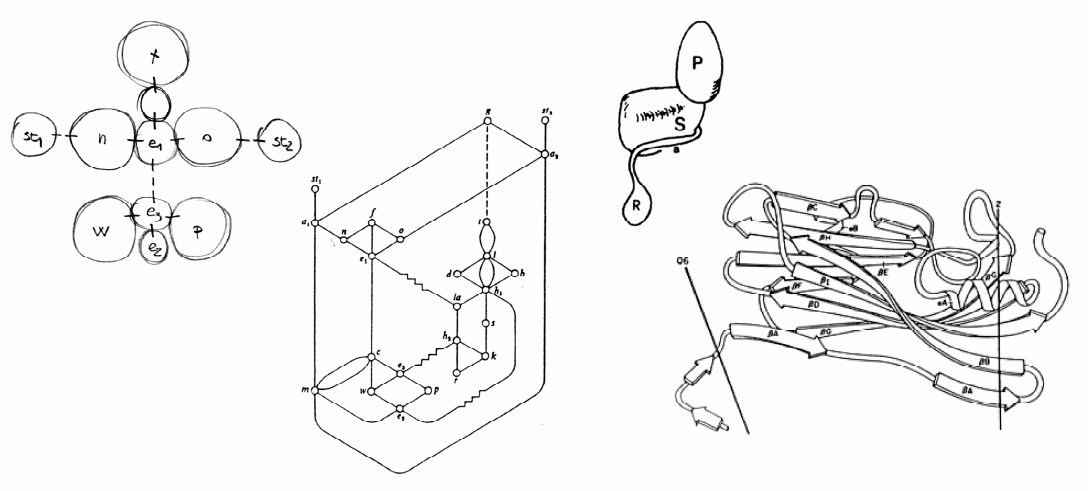
Figure 6. Graphic diagrams of Frank Lloyd Wright’s Devin House and of tomato bushy stunt virus (TBSV) [10] (p. 223), [16] (pp. 132,